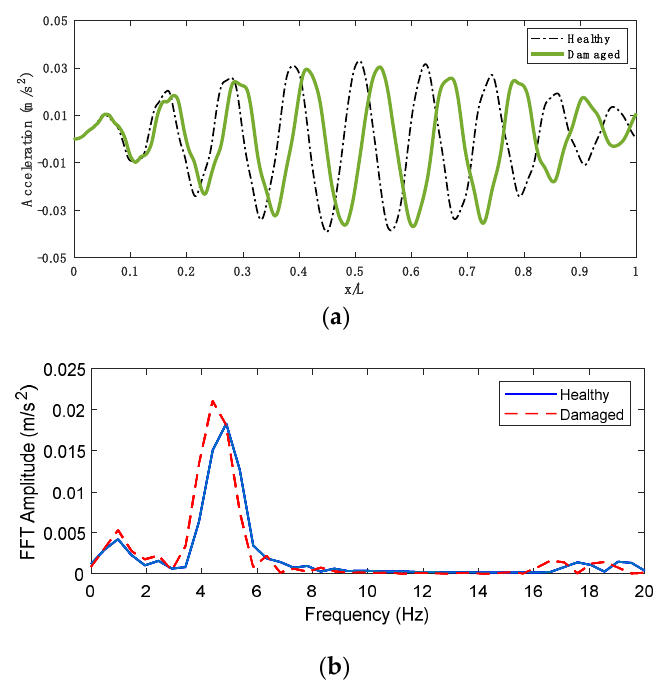
Figure 4. The response measured on the axle of the vehicle passing over healthy and damaged bridges